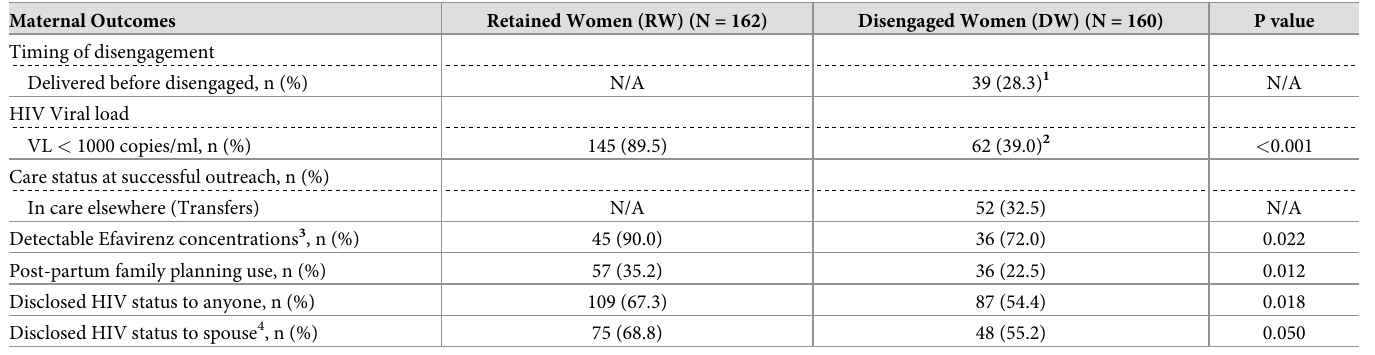
Table 2. Maternal outcomes among retained and disengaged women in a PMTCT program in Uganda. Maternal Outcomes Timing of